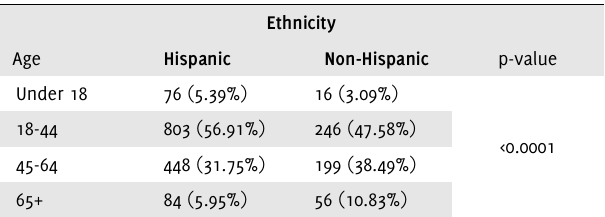
Table 5 . Evaluating the Association Between Age and Ethnicity to Evaluate Age as a Potential